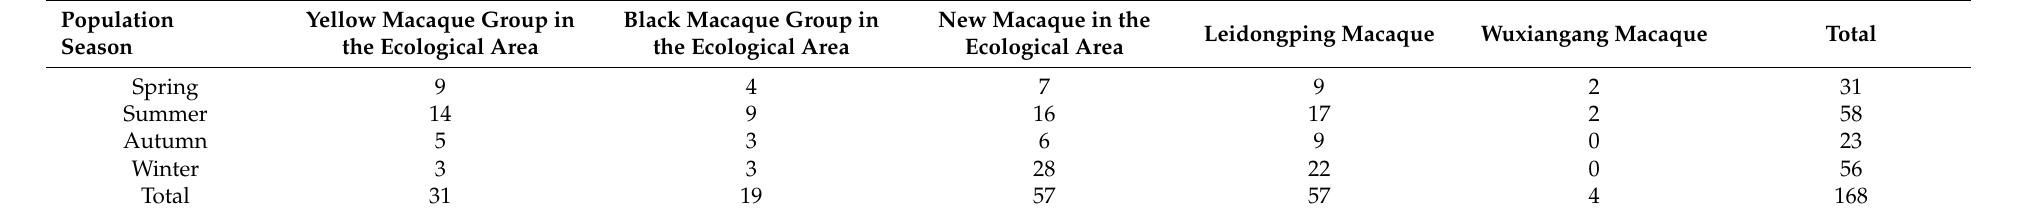
Table 1. Population of monkeys during the four seasons.